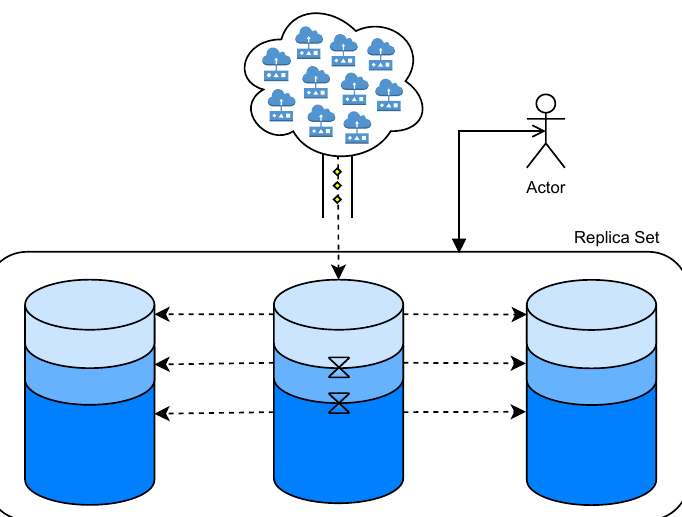
Figure 9. Simplification of a sample database following Cascading Polyglot Persistence when scaling out using traditional replication. Data are ingested directly to Data Model 1 of the primary node for later cascading until the last data model. The whole database is replicated two times, creating a replica set of three